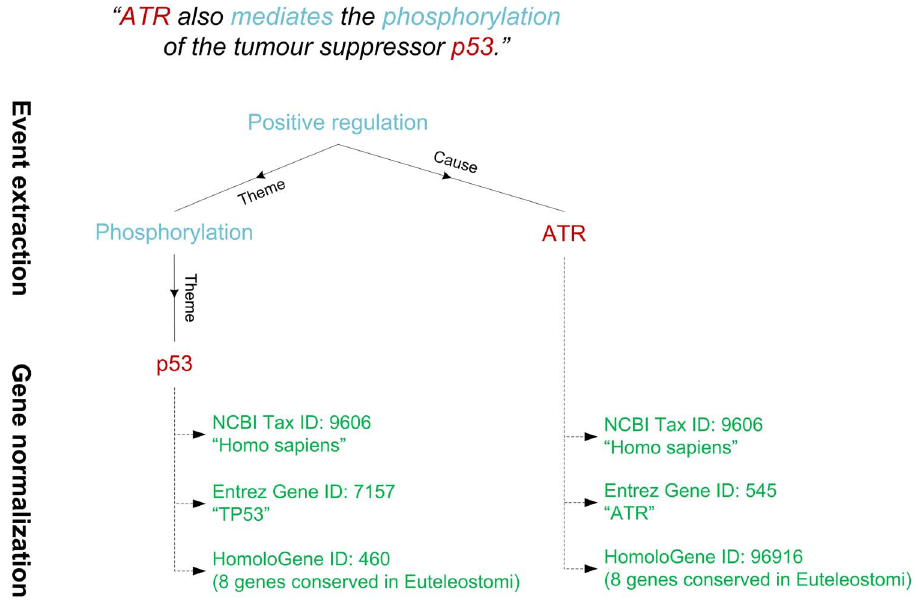
Figure 1. Illustration of event extraction and gene normalization. The gene mentions recognised in text are in red and the extracted event structures in blue. The normalization algorithm further maps the ambiguous gene mentions to unique database identifiers (in green).